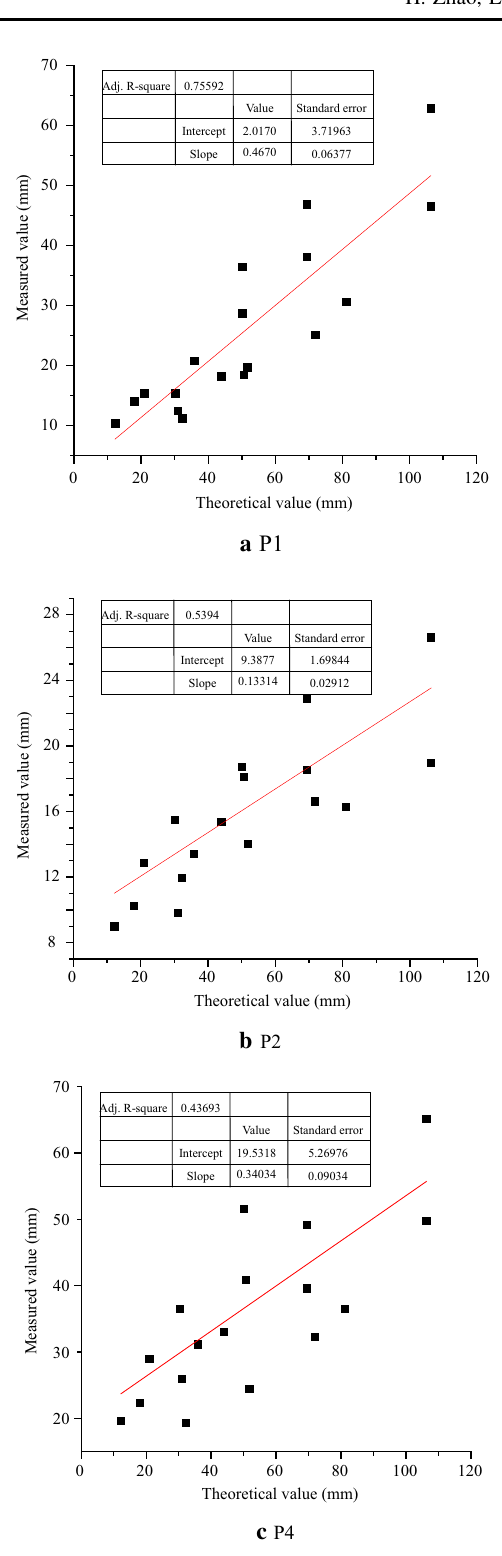
Fig. 5 Linear correlation analysis for theoretical surge height and the measured ones at P1, P2, and P4, which represent, respectively, the characteristics of surge height in sliding zone, propagating zone, and running up